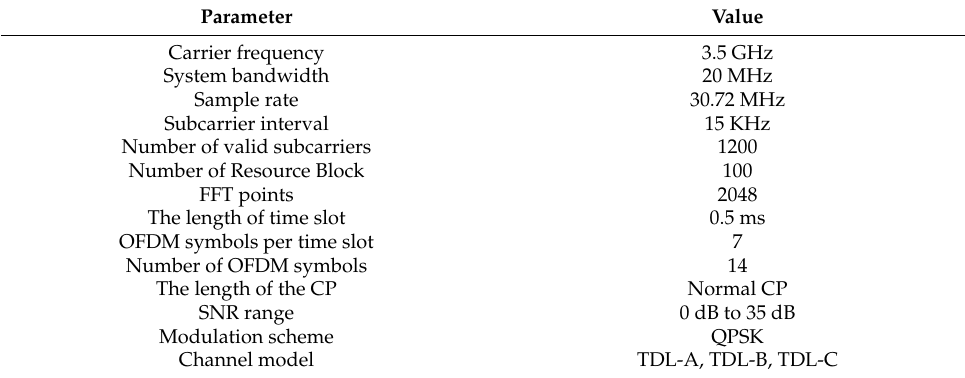
Table 5. Experimental Settings for OFDM signal generation.